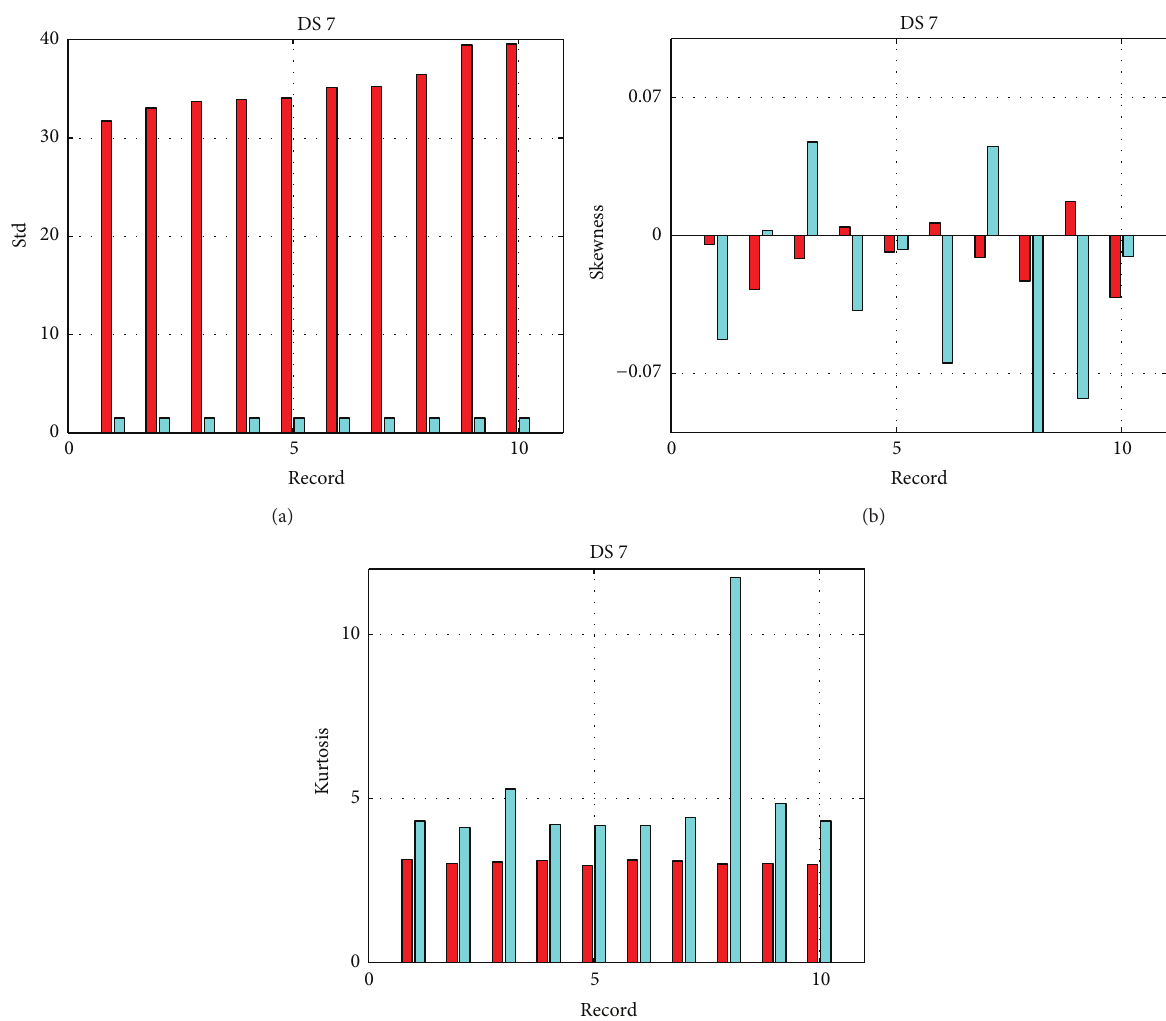
Figure 11: (a) STD, (b) skewness and (c) kurtosis values of the reduced subset for nights #1 (leak, red) and #2 (no leak, cyan) of DS